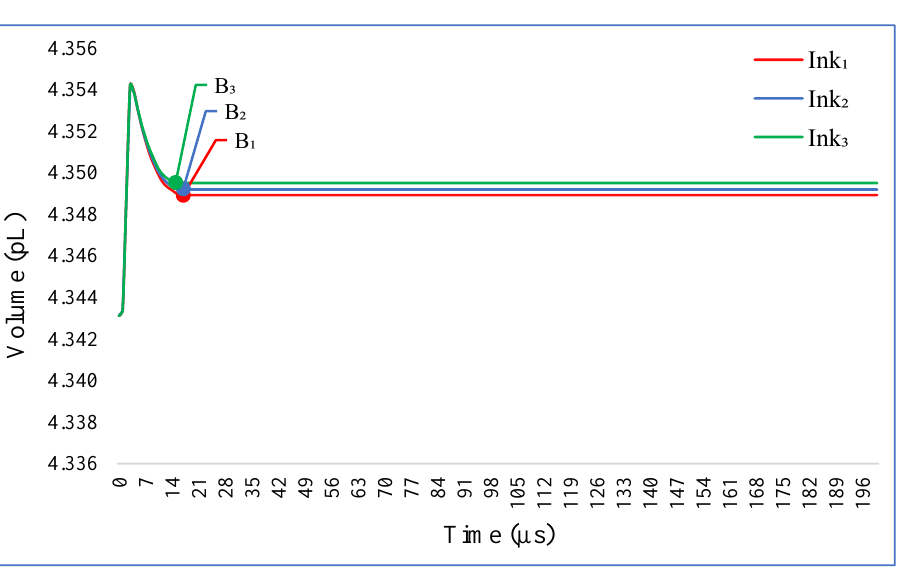
Figure 7. Representation of the mass of the droplets (Ink₁, Ink₂, Ink₃) versus time. Droplet mass is integrated over the computational domain. At point A, the droplet reaches its maximum velocity and the droplet mass starts to increase during the first pe- riod till it reaches point B. At point B, the droplet thread is pulled off from the printing nozzle and mass is fully given. Droplets of different inks increase very similarly (Ink₁ fully formed at 11 μs, Ink₂-13 μs, Ink₃-14 µs). When the liquid droplet is ejected, it needs a cer-